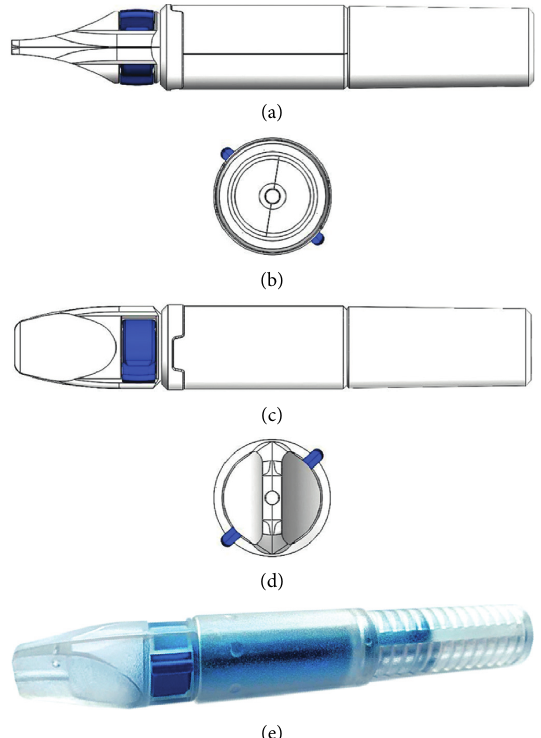
Figure 1: SPAS structure. (a) Top view; (b) back view; (c) side view; (d) front view; (e) 3D view of SPAS, showing the central tunnel and the locker (blue portion) and the “fixator” in the front.